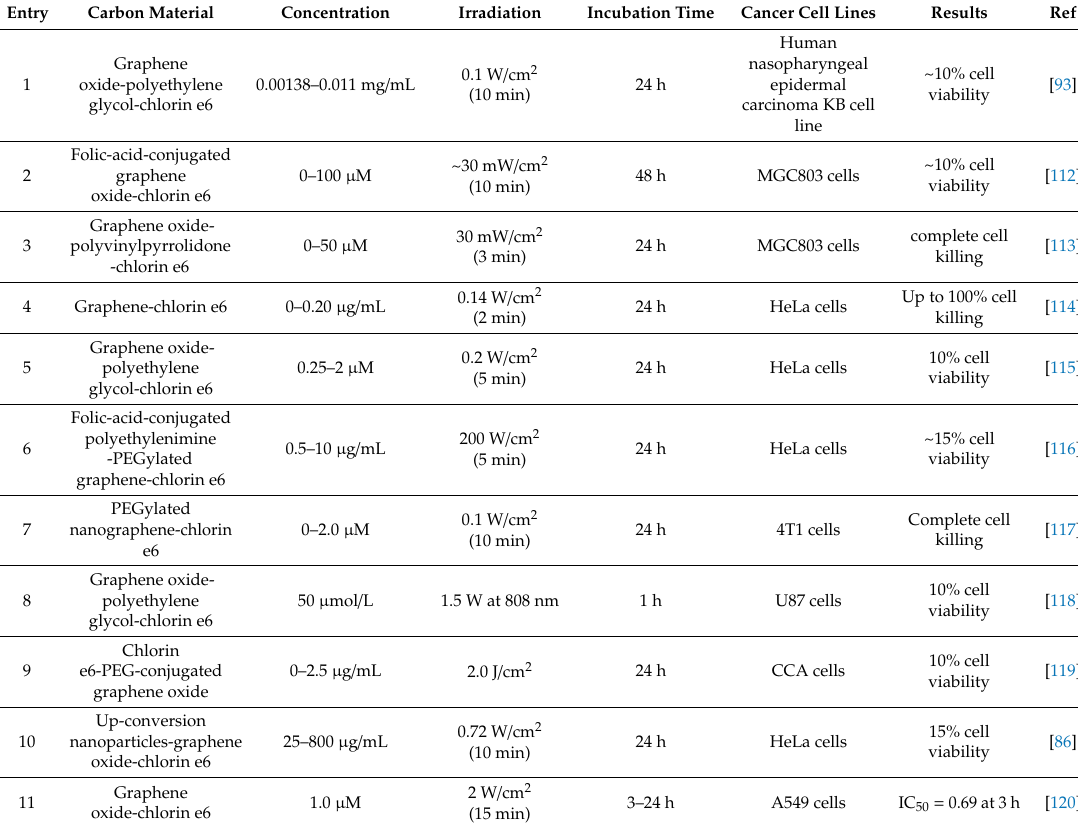
Table 5. Parameters used for chlorin-based photosensitizers immobilized on graphene as a photosensitizer against